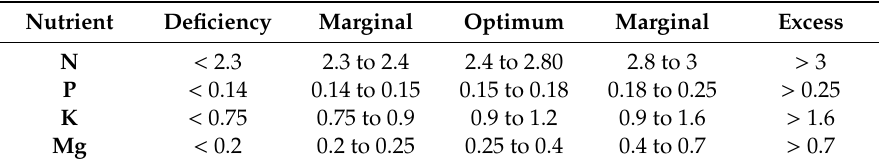
Table 7. Percentages of nutrient concentration in oil palm leaves (over 6